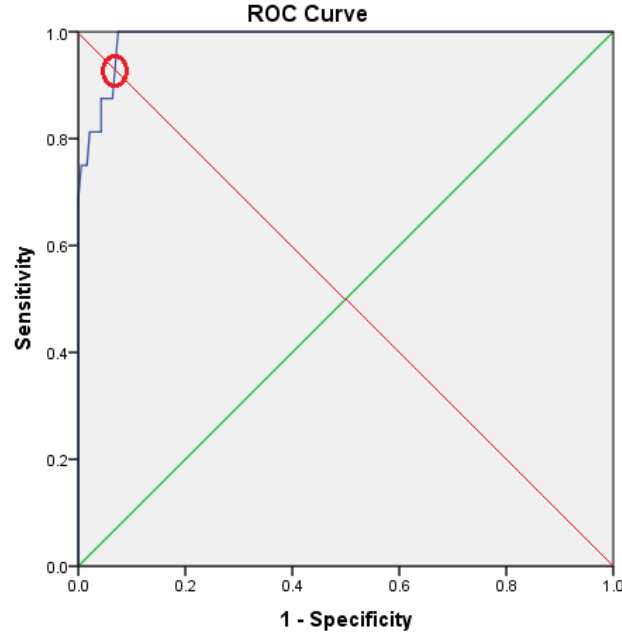
Figure 2. Receiver Operating Characteristic curve.